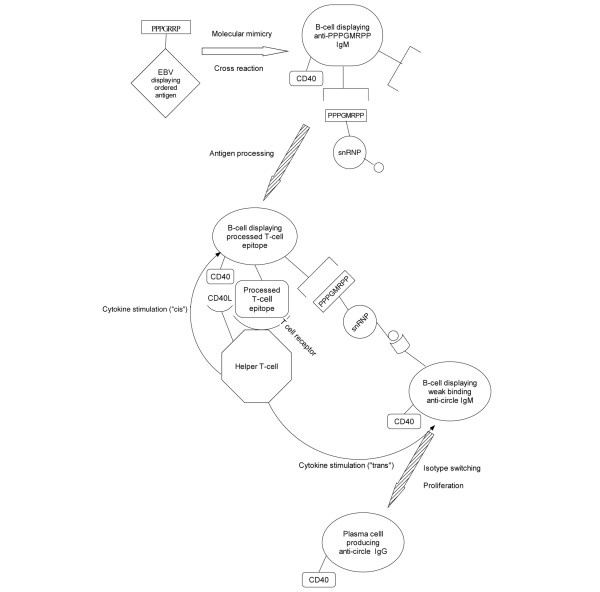
A scaffolding model for antigen spreading. Shown is the target of an autoimmune response; here a snRNP particle that expresses at least two antigenic determinants. The determinant represented by the rectangle, which might be for example the PPPGRRP sequence on EBNA1, is assumed to cross react with the determinant PPPGMRPP on the snRNP via a conventional immune synapse. We denote progenitor B cells participating in these cognate interactions with T cells as primary progenitor B cells. Also shown is a second determinant on the small nuclear ribonucleoprotein particle (snRNP; represented by a circle) that is assumed to be more strongly disordered than the rectangular determinant. Progenitor B cells reacting with this determinant, termed secondary progenitor B cells, are capable of spreading the immune response via an eavesdropping mechanism as discussed in the text. EBV, Epstein-Barr virus.